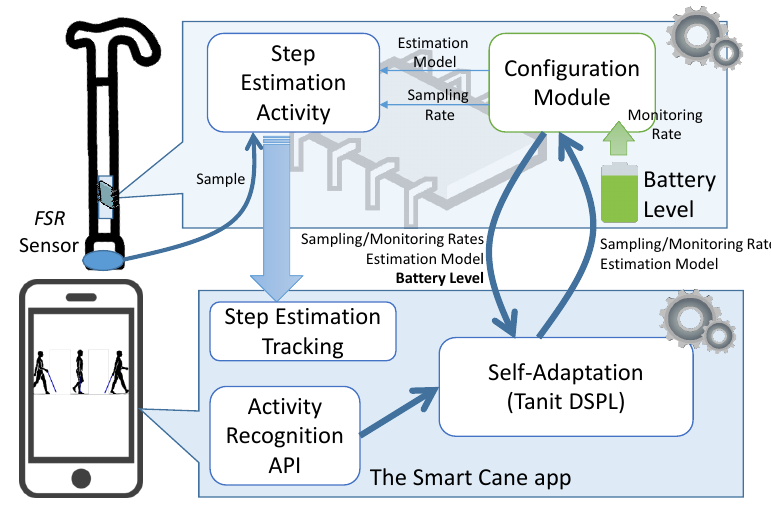
Figure 2. Overall picture of our